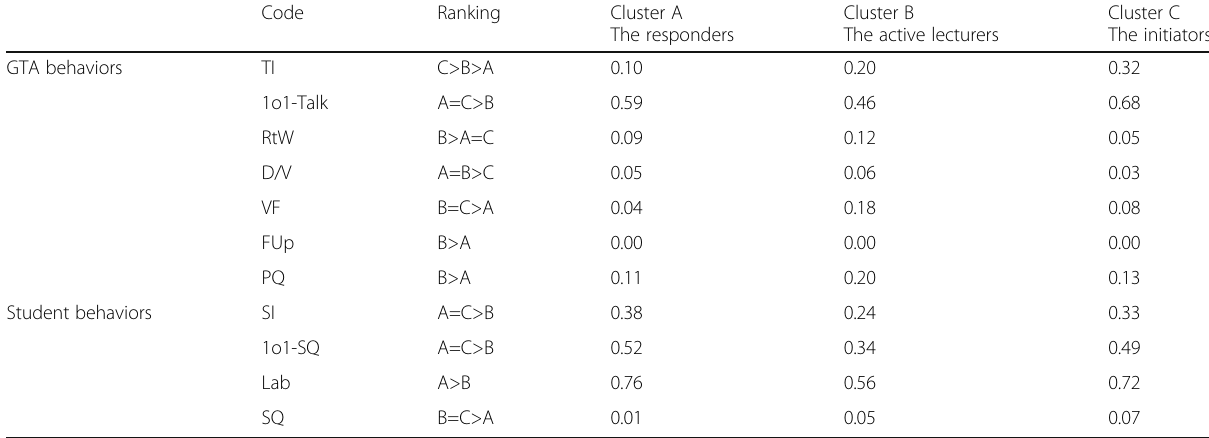
Table 7 Median fractions in each cluster of chemistry labs. The ranking of clusters for each code is determined by Dunn ’ s test with Holm-Bonferroni